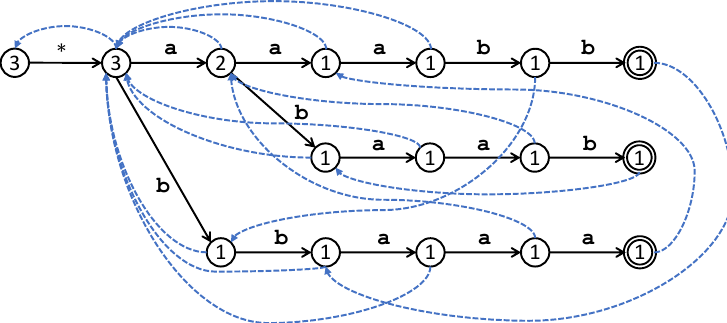
Figure 2. The multi-track permuted matching automaton MTPMA ( P ) for P = ( aaabb , abaab , bbaaa ) . The asterisk is a special symbol that matches with any symbols in Σ